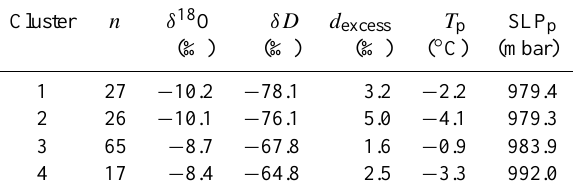
Table 7. Mean isotopic composition of backward trajectory clus- ters, each cluster contains n single events. Temperature ( T p ) and air pressure (SLP p ) correspond to the precipitation day